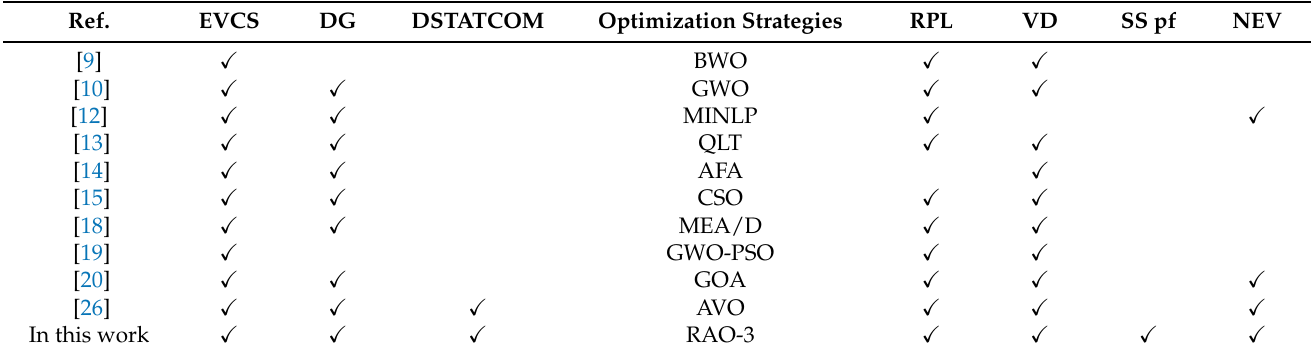
Table 1. An overview of the research gap analysis and the authors’ contributions.